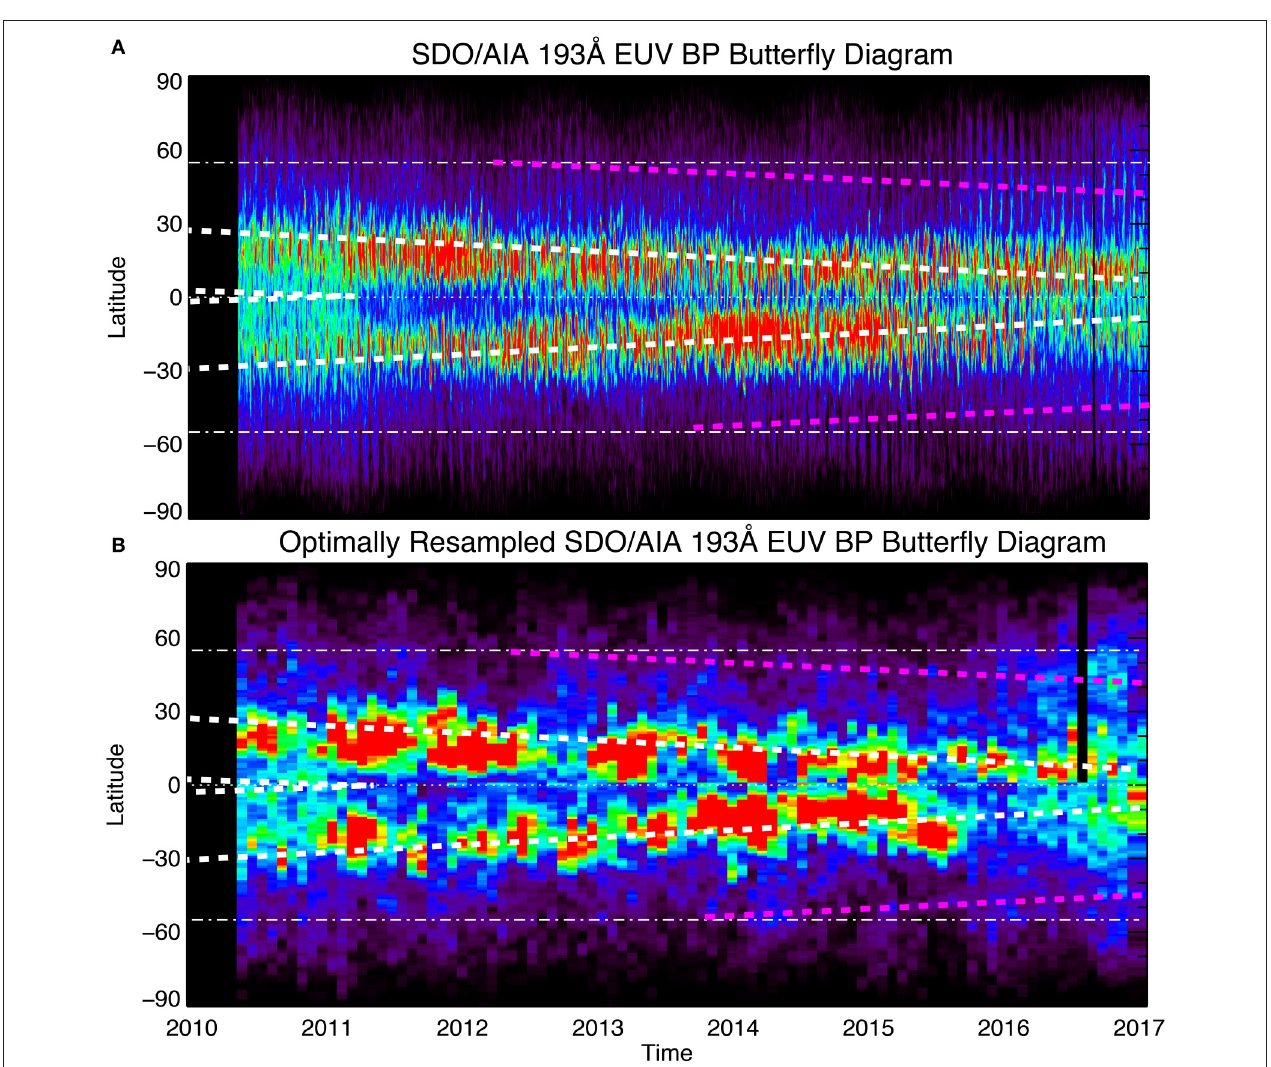
FIGURE 5 | Comparing the (A) SDO /AIA BP density butterfly diagram (top; see e.g., Figures 1 , 2 ) with an (B) optimized butterfly diagram (bottom) constructed using the properties derived from Figure 4 . In each panel, we show the white and pink dashed lines that form the guidelines for the extended solar cycle, cycles 24 and 25,